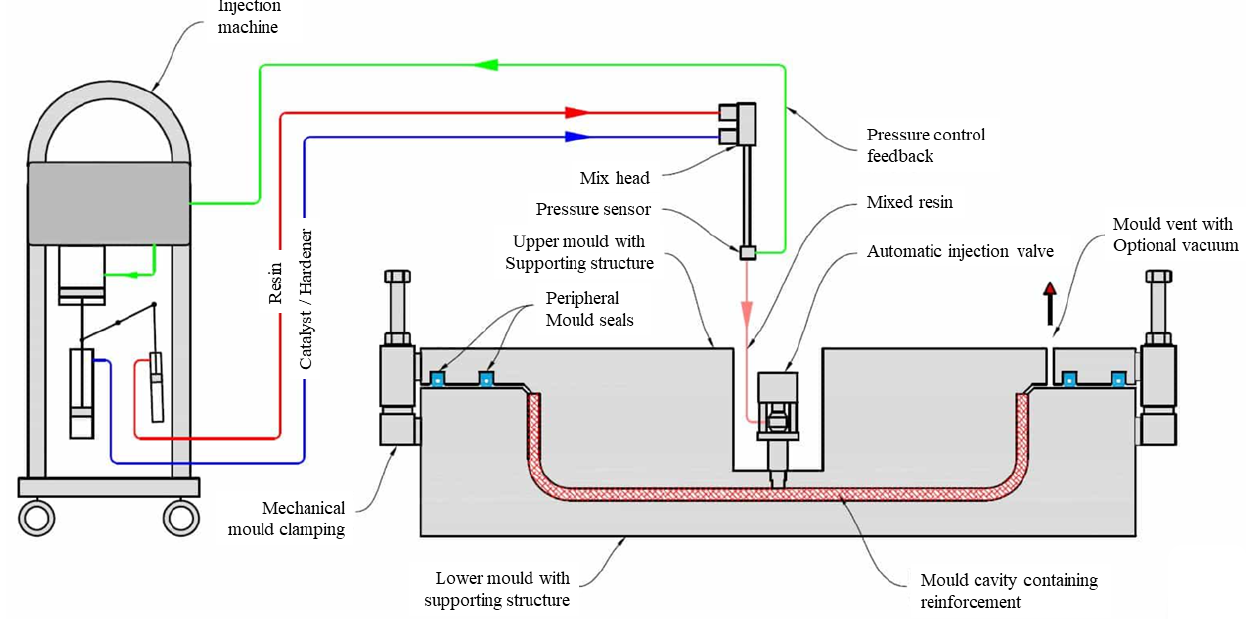
Figure 10. RTM molding process principle (composite-integration.co.uk/resin-transfer-molding).